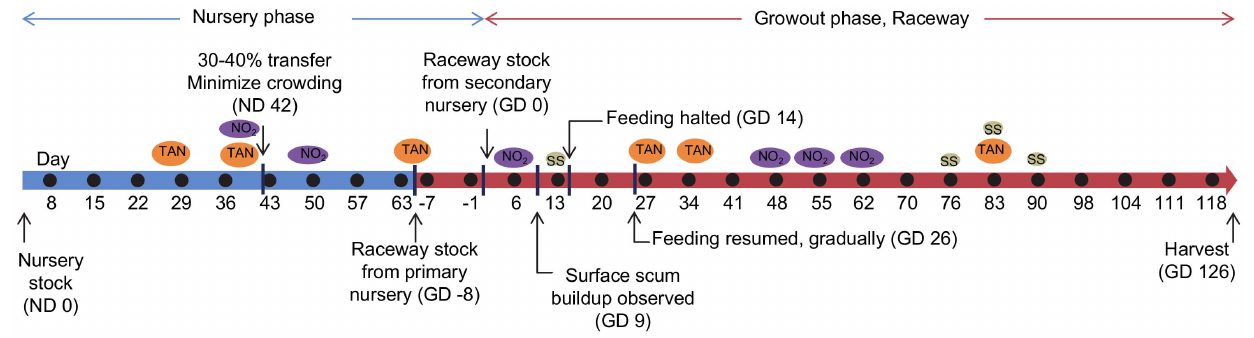
N Figure 1. Growout timeline. Experimental design of the shrimp aquaculture growth study from the nursery phase through the raceway growout : biological composites (nursery) or shrimp muscle tissue (growout) were analyzed. ND: phase to harvest. Circles represent shrimp collection days, nursery phase day; GD: growout phase day. Important events are noted with arrows and text. Water quality changes are illustrated as colored circles above the timeline, TAN: a spike in total ammonia nitrogen levels; NO 2 : a spike in nitrite levels, SS: an increase in suspended solids.